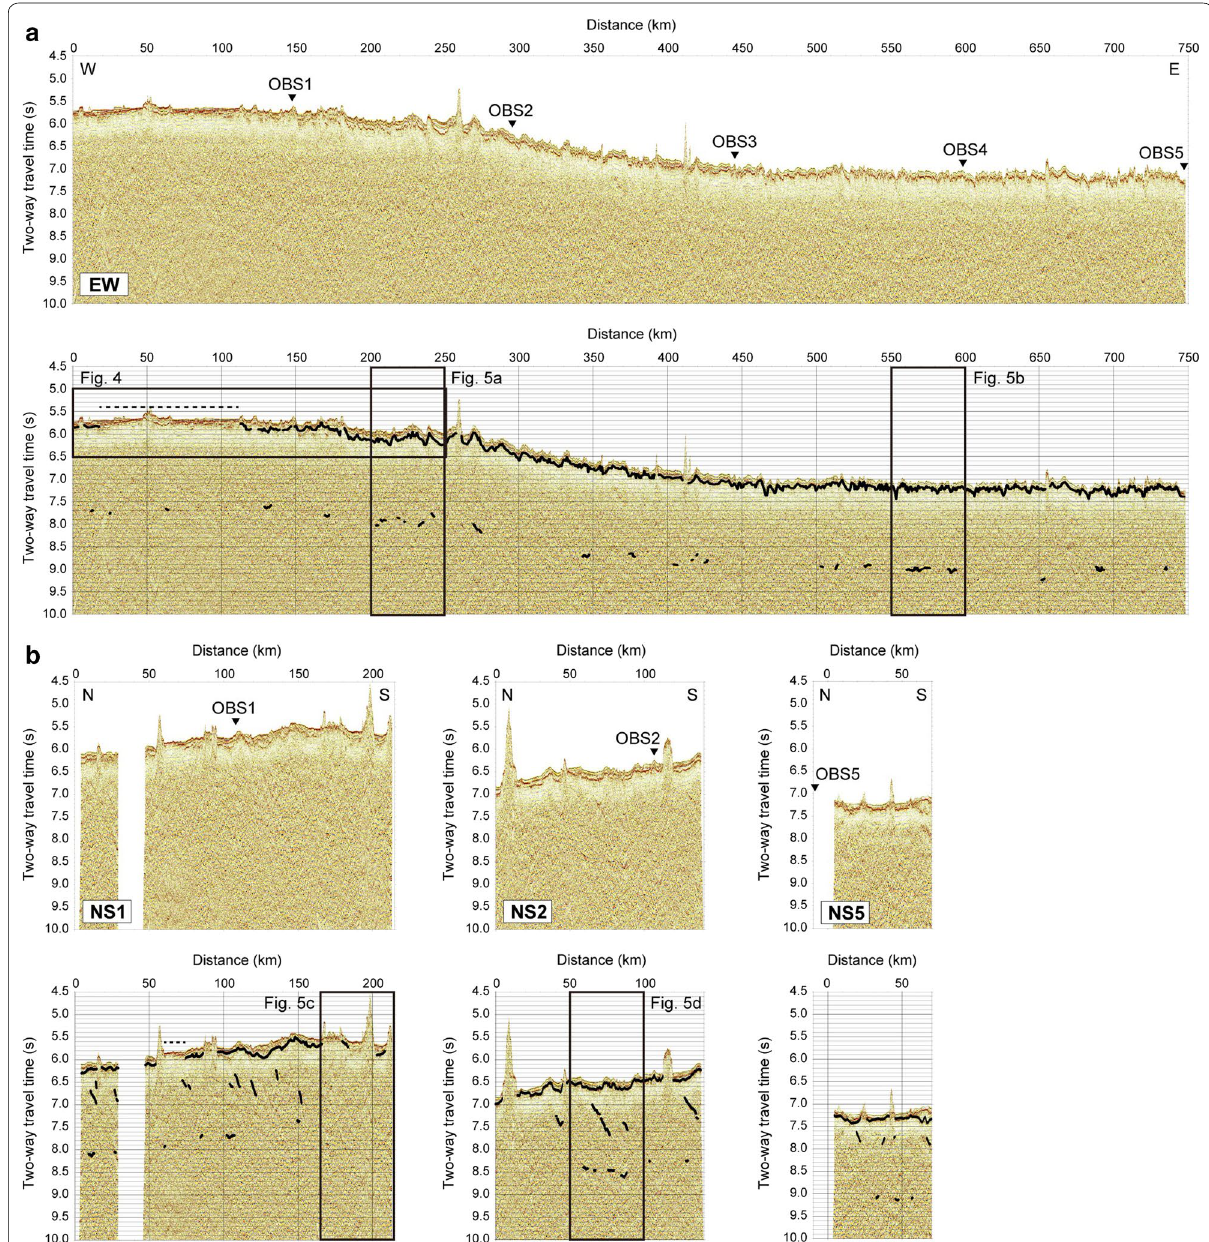
Fig. 2 Multi-channel seismic reflection images of a the EW line and b the NS lines. In the lower panels, black lines are used to highlight prominent seismic reflectors on the sections. Dashed lines indicate areas where the reflectivity is high at the seafloor and the basement. Rectangles indicate areas shown in Figs. 4 and